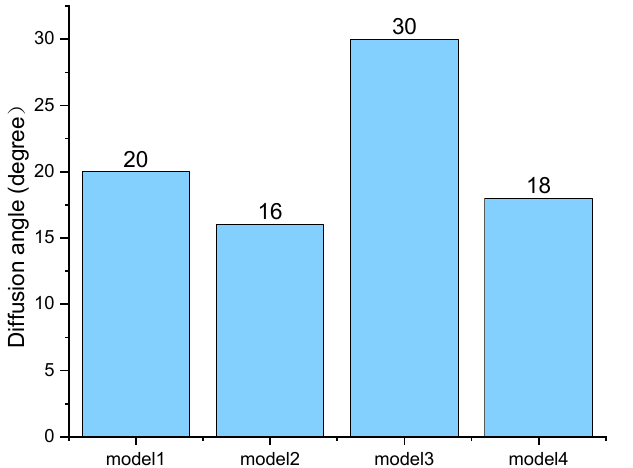
Figure 8. Comparison of R p of the injected fuel in the domain at the inlet velocity of 300 m/s.